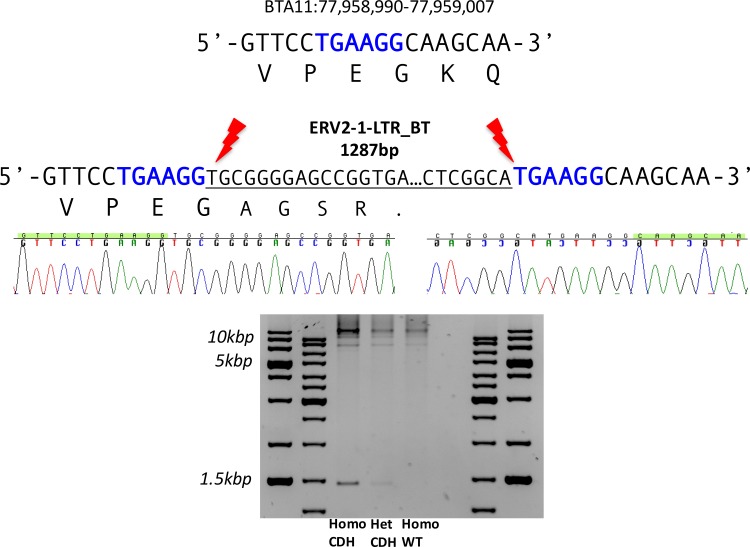
Schematic drawing of the retroviral insertion in APOB exon 5 causing CDH.The wind-type sequence and amino acid translation is shown on top (location on BosTaurus_UMD3.1/bosTau6). The insertion breakpoints of the ERV2-1-LTR_BT are shown below. The insertion causes a premature stop codon. The 6bp target site duplication indicative of an integrase mediated insertion is highlighted in blue. The chromatograms are obtained from Sanger-sequencing of a 1,461bp amplicon that was obtained with primers unique to the flanking region of the putative insertion site. As shown in the agarose gel image this band was amplified in CDH homozygous/heterozygous animals but is not present in the wild-type control animal.